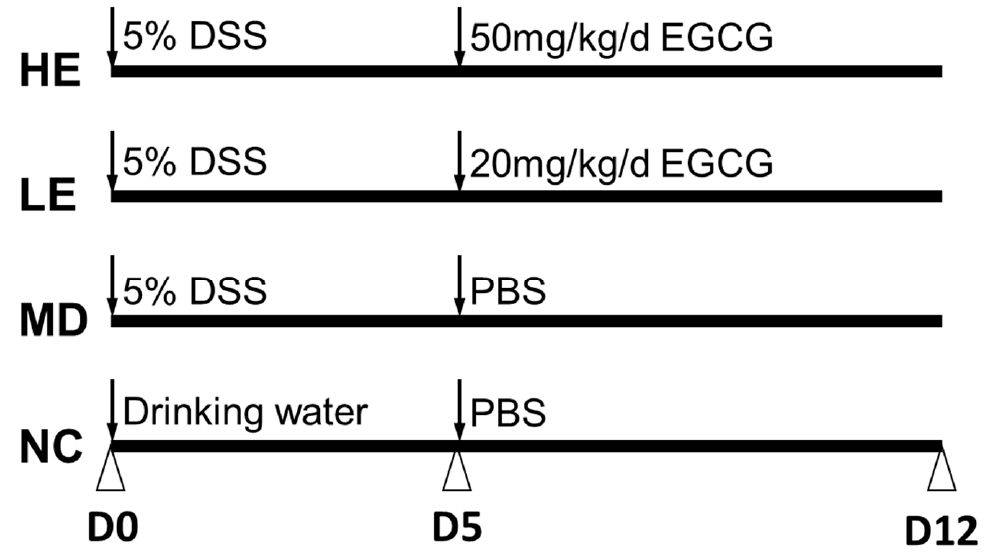
Figure 1. Epigallocatechin gallate (EGCG) treatment schedule for the study. Mice were randomly divided into four groups based on body weight. Normal control group mice (NC) were given normal drinking water from Day 0 to Day 5 followed by oral gavage with phosphate buffered saline (PBS) from Day 5 to Day 12. Dextran sulfate sodium (DSS)-induced colitis model group mice (MD) were administered 2.5% DSS containing drinking water from Day 0 to Day 5 followed by oral gavage with PBS from Day 5 to Day 12. Low-dose (LE) and high-dose (HE) EGCG treatment groups of mice were given 2.5% DSS containing drinking water from Day 0 to Day 5 followed by oral gavage with 20 mg/kg/d and 50 mg/kg/d EGCG, respectively, from Day 5 to Day 12.